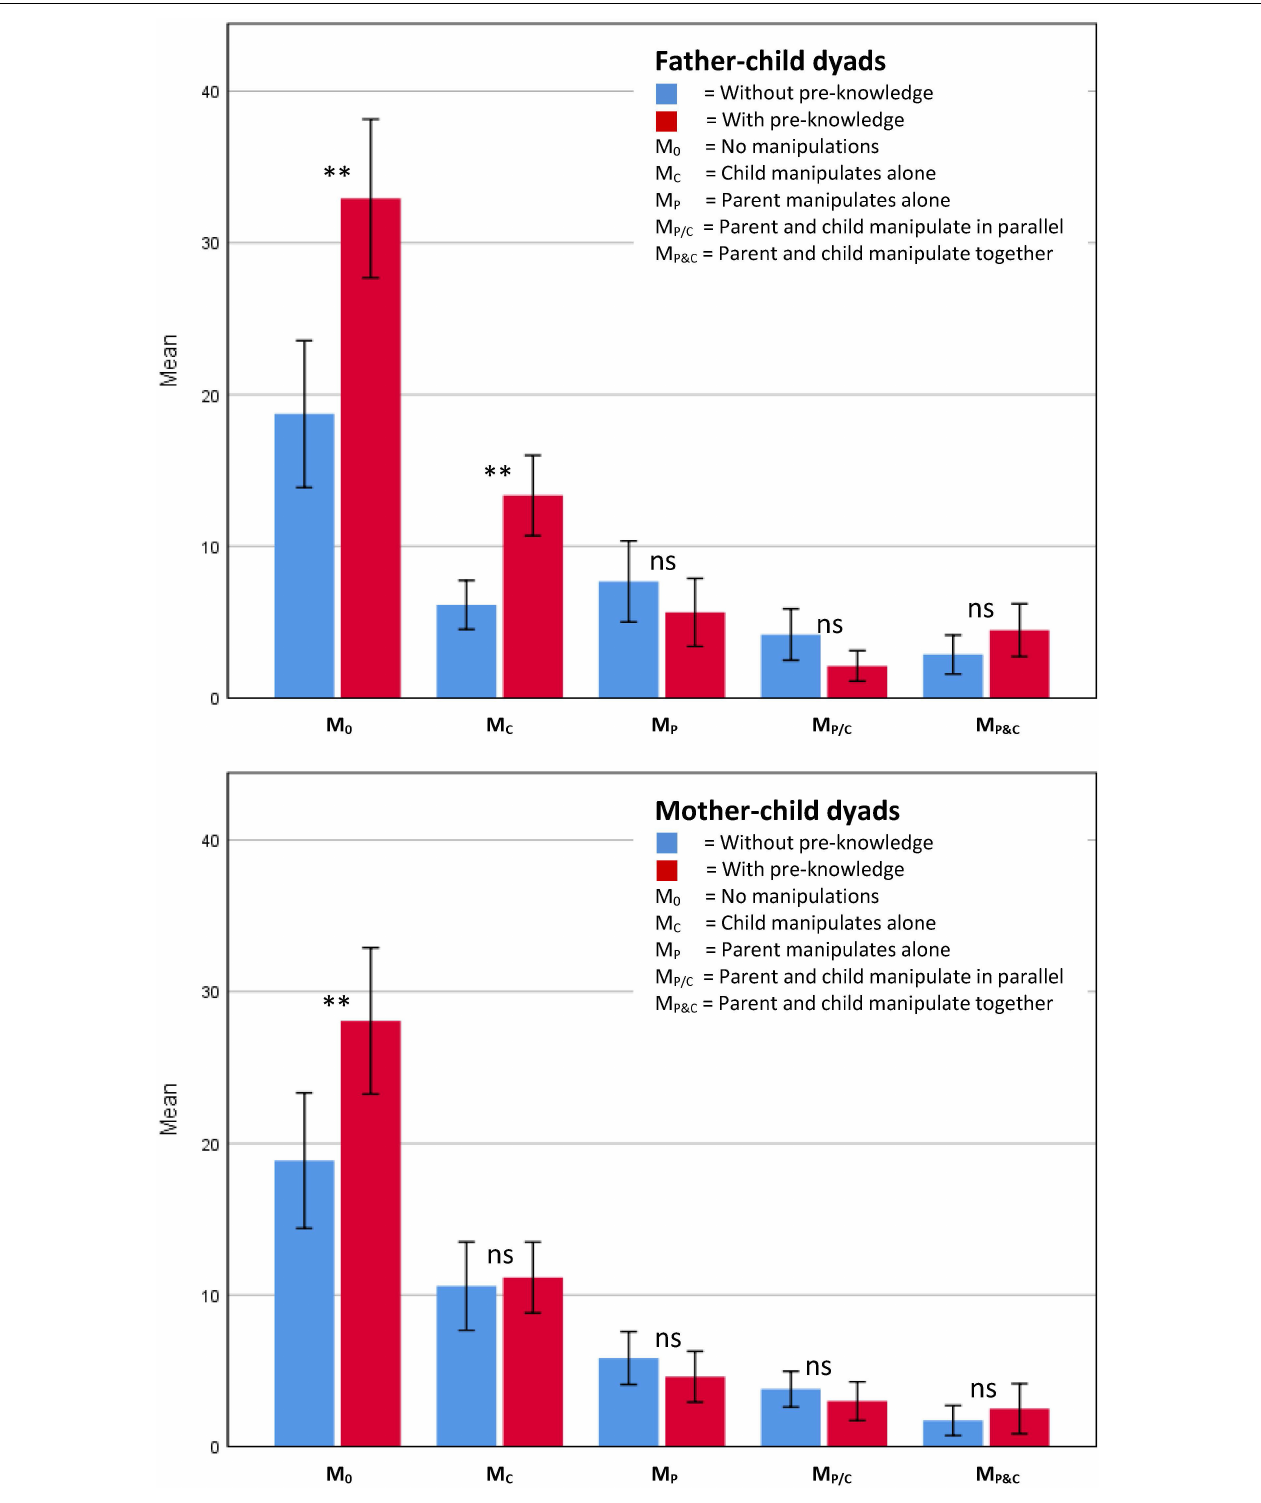
FIGURE 2 | Parental pre-knowledge and parental gender interaction on manipulations. (A) Father–child dyads ( N = 50). (B) Mother–child dyads ( N = 55). Mean values of the five manipulation categories (M 0 , M C , M P , M P / C , and M P&C ) for the two pre-knowledge conditions (blue = Control condition without parental pre-knowledge, red = Experimental condition with parental pre-knowledge). Error bars = 95% CI. Significances for differences between pre-knowledge conditions are depicted: ns p > 0.05; ** p ≤ 0.01.